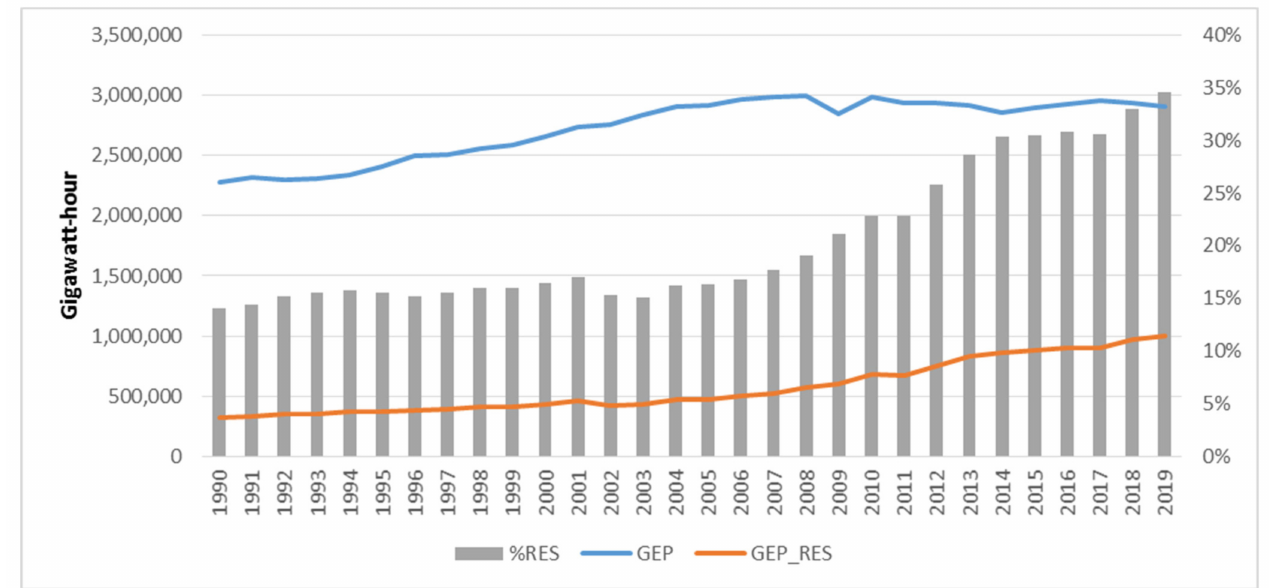
Figure 1. Gross electricity production (GEP), gross electricity production from renewables and biofuels ( GEP_RES ), and share of gross electricity production from RES in the total gross electricity production (%RES) in 1990–2019 in the European Union (EU-27). Source: Reference